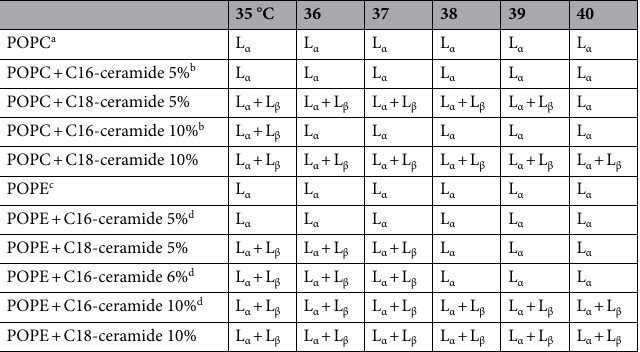
Table 2. Lipid phase of C16-ceramide or C18-ceramide-containing POPC and POPE. References: a47–50 , b40 , c44,51–54 , d44